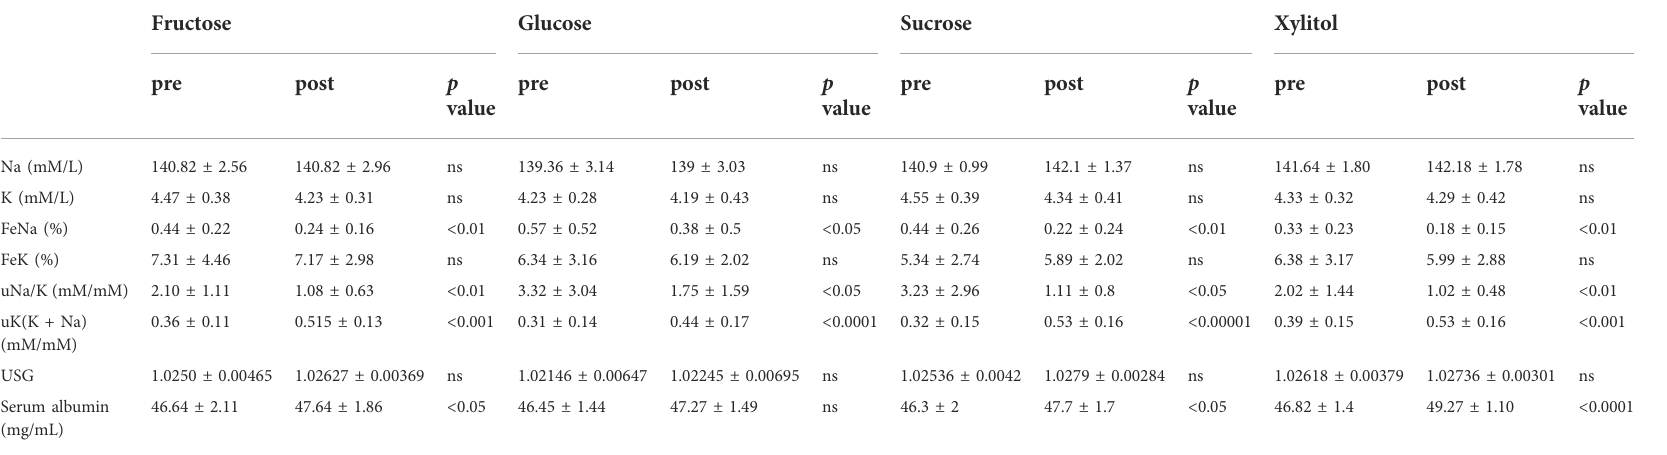
Abbreviations: USG, urine special gravity, ns-non signi fi cant.